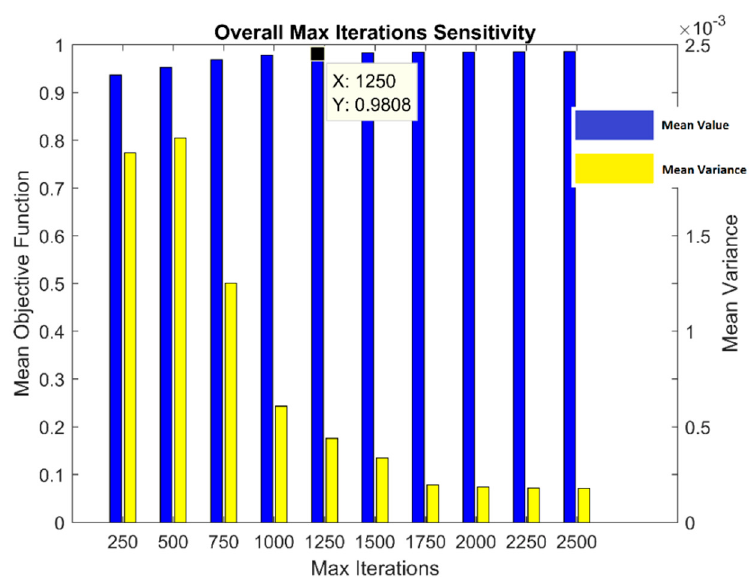
Figure 10. Sensitivity analysis of PSO evaluating the Initial Swarm Span.